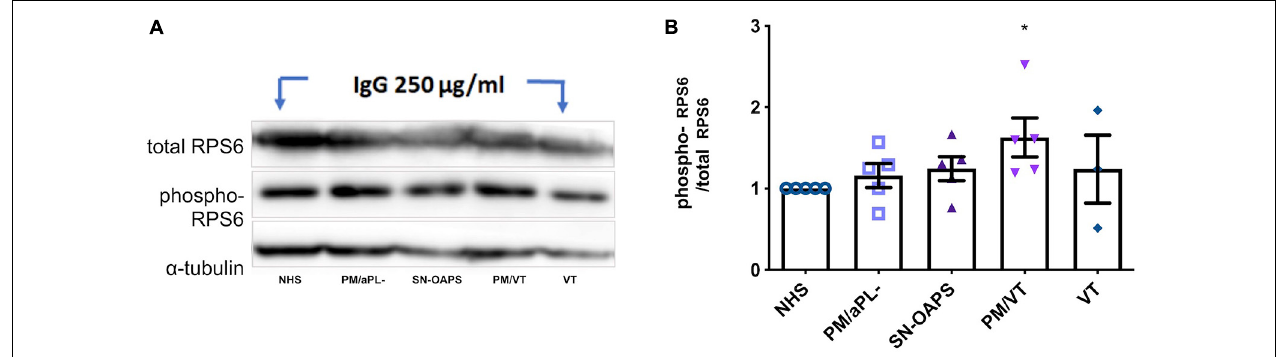
FIGURE 2 | Activation of mammalian target of rapamycin (mTOR) pathway is induced by aPL in endothelial cells. HUVECs were stimulated with 250 µ g/ml polyclonal IgG from women with clinical features of APS and control groups. Protein expression of the total and phosphorylated forms of the effector ribosomal protein S6 (RPS6) was assessed by Western blot. (A) Representative blot. (B) Scatter plot shows the phospho/total RPS6 ratio. PM/VT IgG increased the RPS6 phosphorylation in comparison with the NHS IgG, which means that activates the mTOR pathway. Data are shown as mean ± SEM ( n = 5; * p < 0.05 vs. NHS from one-way ANOVA and Dunn’s